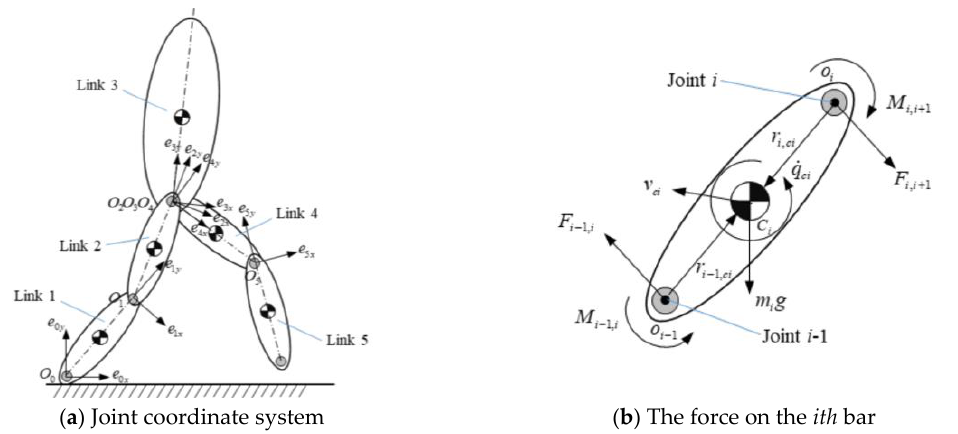
Figure 9. The five-bar human dynamic model.